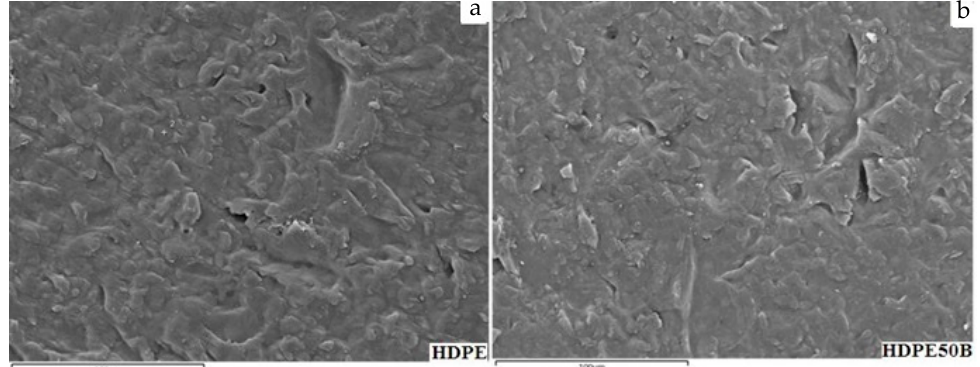
Figure 4. SEM of ( a ) virgin HDPE and ( b ) HDPE containing 50% birch fiber. Table 3. Contact angle and surface energy of HDPE/birch composites.